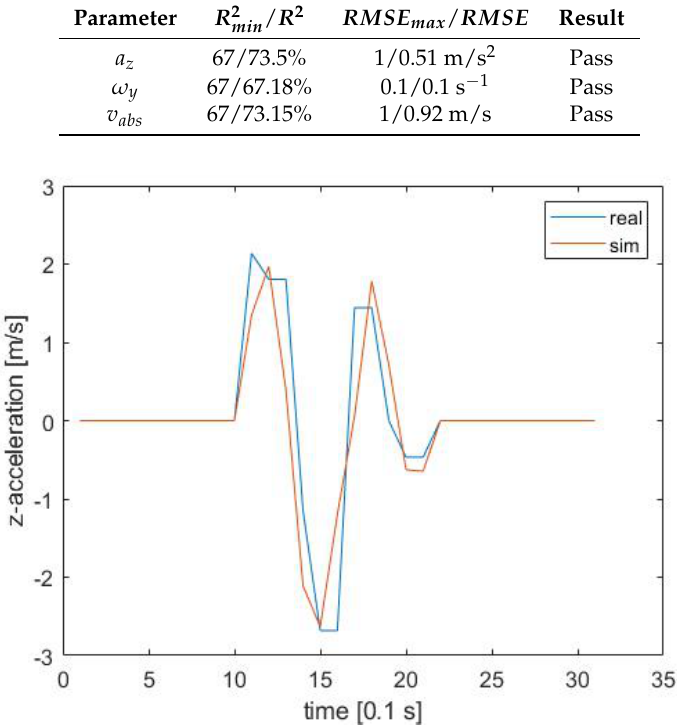
Figure 3. Comparison of vertical acceleration values recorded during the real-world field trial and the one obtained using simulation in Scenario 1 ( R 2 = 69.76%, RMSE = 0.52 m/s 2